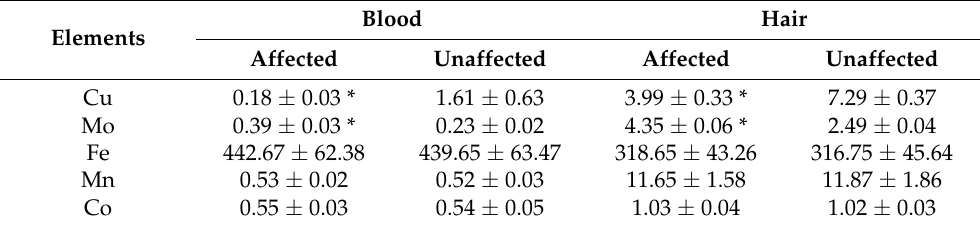
Table 2. The mineral element in blood and hair in gazelles ( µ g/g). Elements